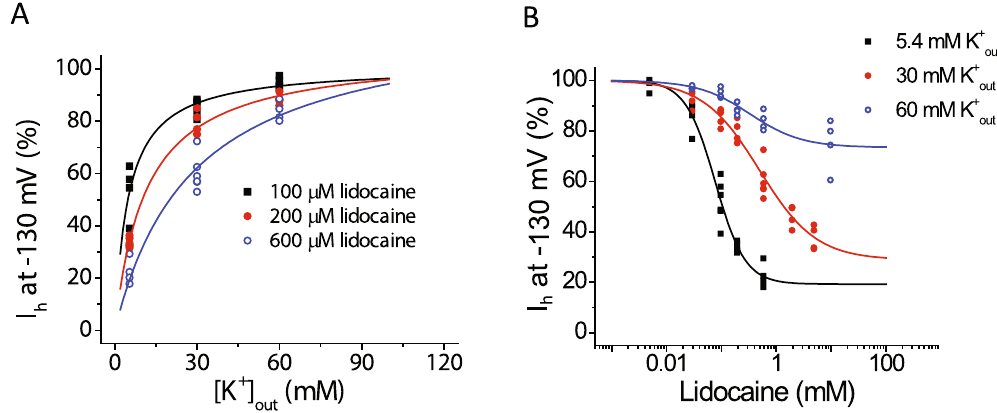
Figure 5. The concentration-response curve for the effects lidocaine and extracellular potassium on HCN1- mediated I h at − 130 mV demonstrates changes that are consistent with an interaction between them. ( A ) Plots of I h amplitude at − 130 mV versus concentration of extracellular potassium concentration in the presence of given concentrations of lidocaine (100, 200, and 600 µ M). The solid lines represent fits to the Michaelis-Menten equation. An increase in the concentration of lidocaine from 100 to 600 µ M resulted in an increase in the apparent dissociation constant of potassium from 5.3 ± 0.5 to 27.3 ± 8.9 mM (n = 4–6; ANOVA, P < 0.0001). ( B ) Plots of percent I h inhibition at − 130 mV versus lidocaine concentration. The solid line represents a fit using the Hill equation, which yielded values for IC 50 of 78 ± 7, 495 ± 133, and 332 ± 151 µ M (n = 4–6 cells; ANOVA, P < 0.0001) and estimated Hill coefficients of 1.6 ± 0.2, 0.84 ± 0.12, and 0.92 ± 0.3 at 5.4, 30, and 60 mM extracellular potassium, respectively. Lidocaine’s estimated maximum inhibition was also lower at the higher concentrations of extracellular potassium, declining from 80.7 ± 3.5 to 71.1 ± 5.9% and to 26.6 ± 3.4% upon raising the extracellular potassium concentration from 5.4 to 30 mM, and to 60 mM,